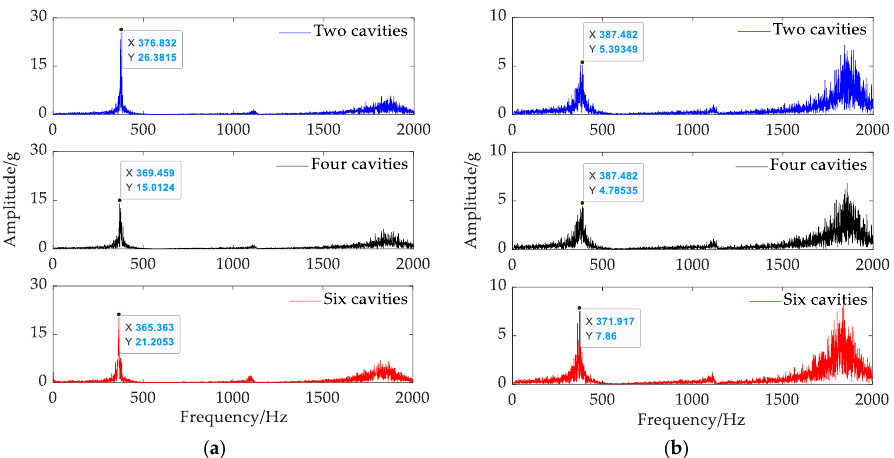
Figure 14. Three particle impact damper structures. ( a ) Two cavities; ( b ) Four cavities; ( c ) Six cavities.